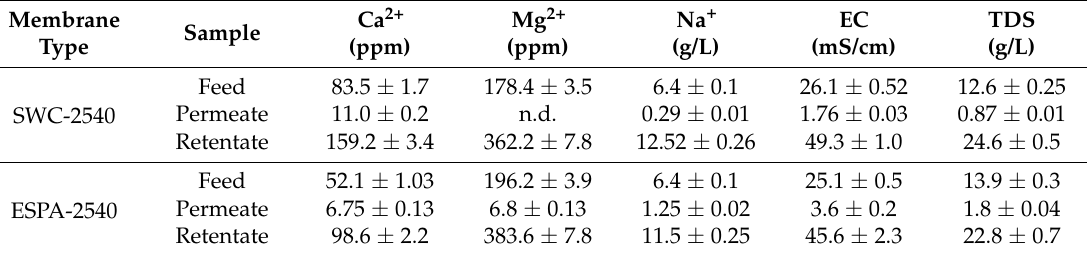
Table 4. Chemical composition of FGD wastewaters before and after RO